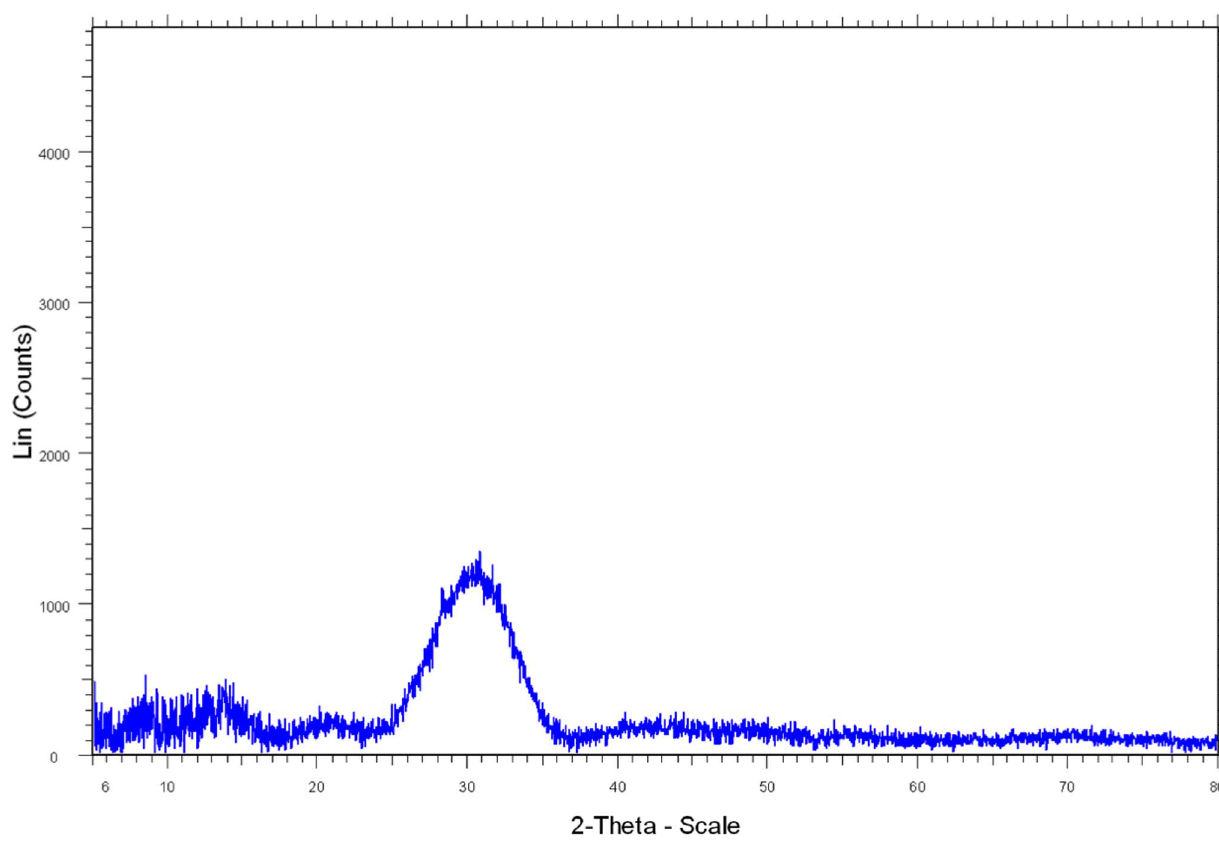
Figure 4. XRD pattern of the dried precipitate formed and sampled after 30 days of aging in the sterile DSMZ medium.